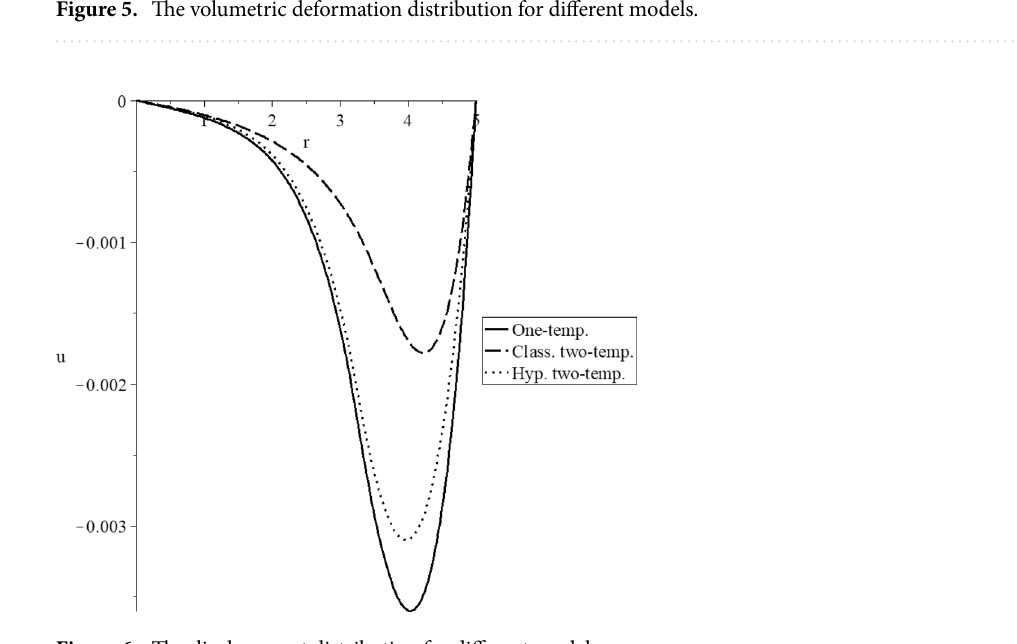
Figure 6. The displacement distribution for different